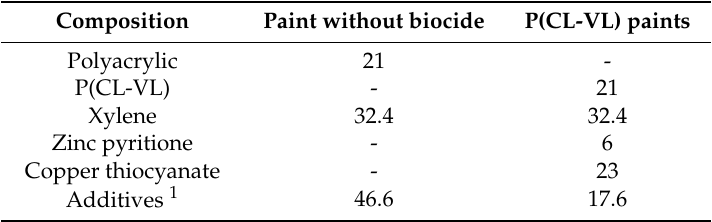
Table 1. Composition of paints (wt